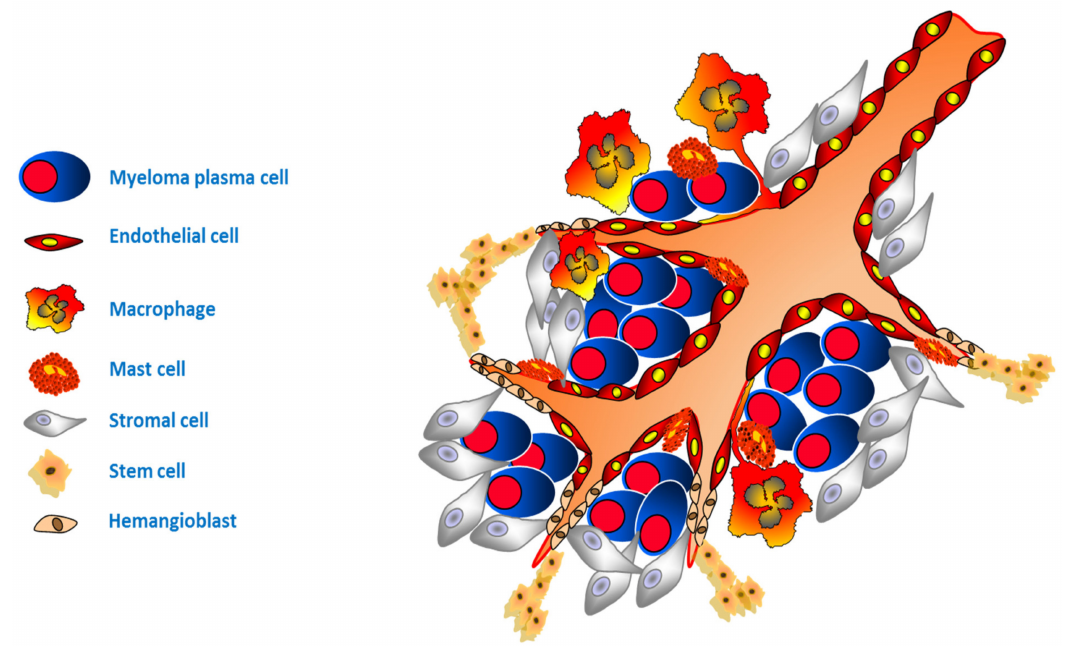
Figure 1. The “vascular niche”. In the pathologic bone marrow (BM), endothelial cells collaborate with other subtypes of stromal cells to assemble the vascular niche in which multiple myeloma (MM) plasma cells are stimulated to proliferate and survive, and are protected from the aggression of anti-myeloma drugs and immune